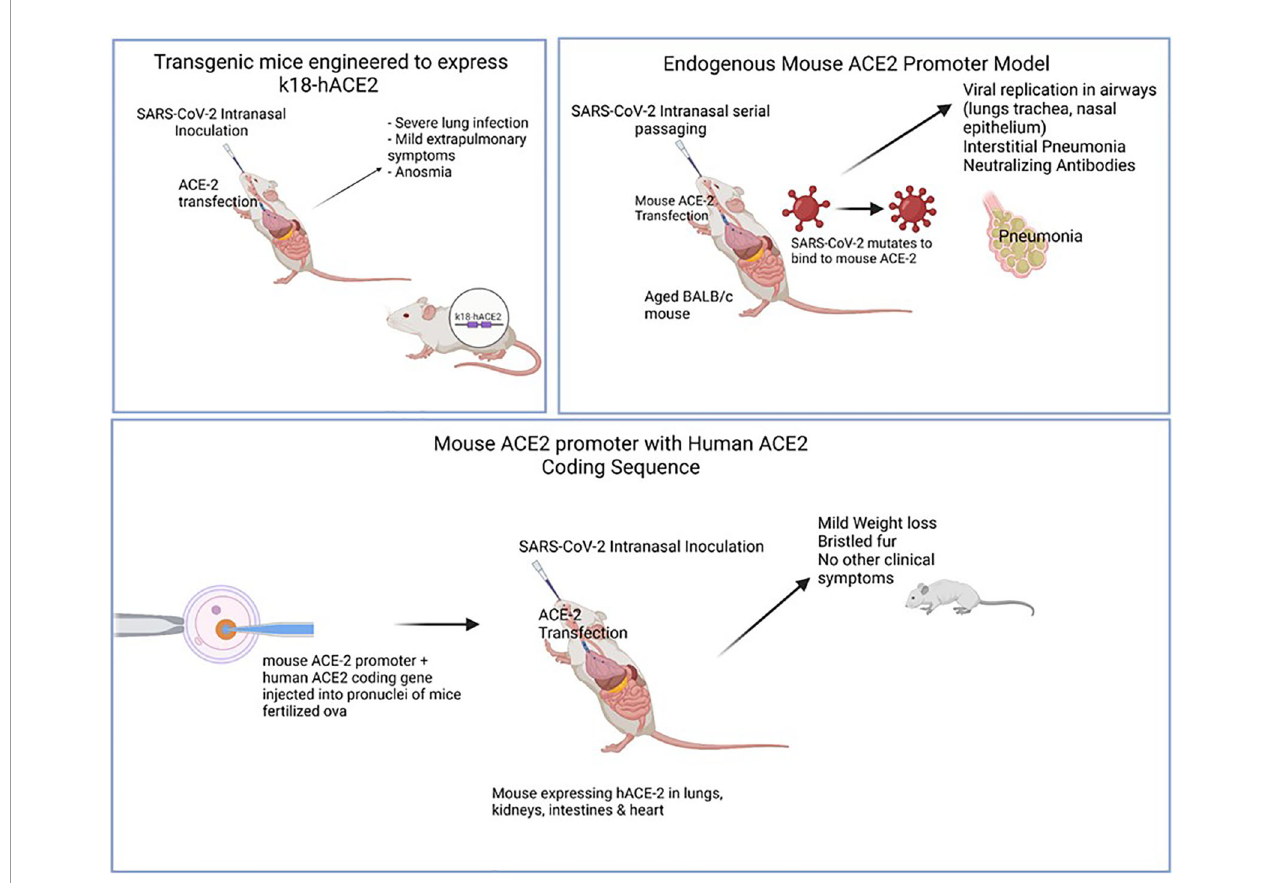
Figure 3 for comparison of animal